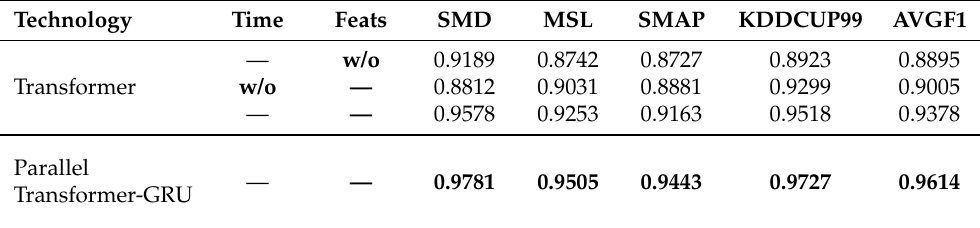
Table 5. The ablation results (F1) of each part of the model on different datasets. Technology Time Feats SMD MSL SMAP Transformer